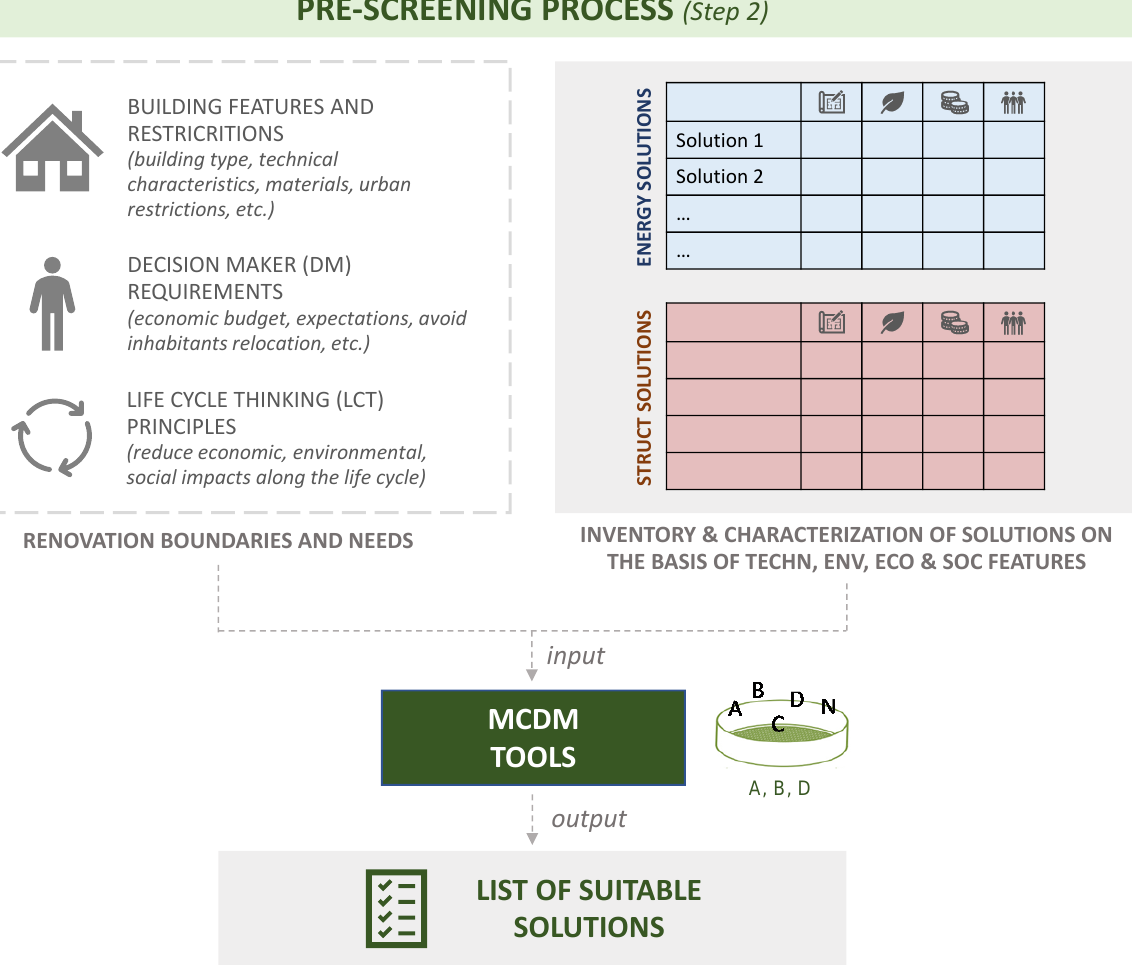
Figure 3. Workflow of the pre-screening process to select the most suitable strategies.